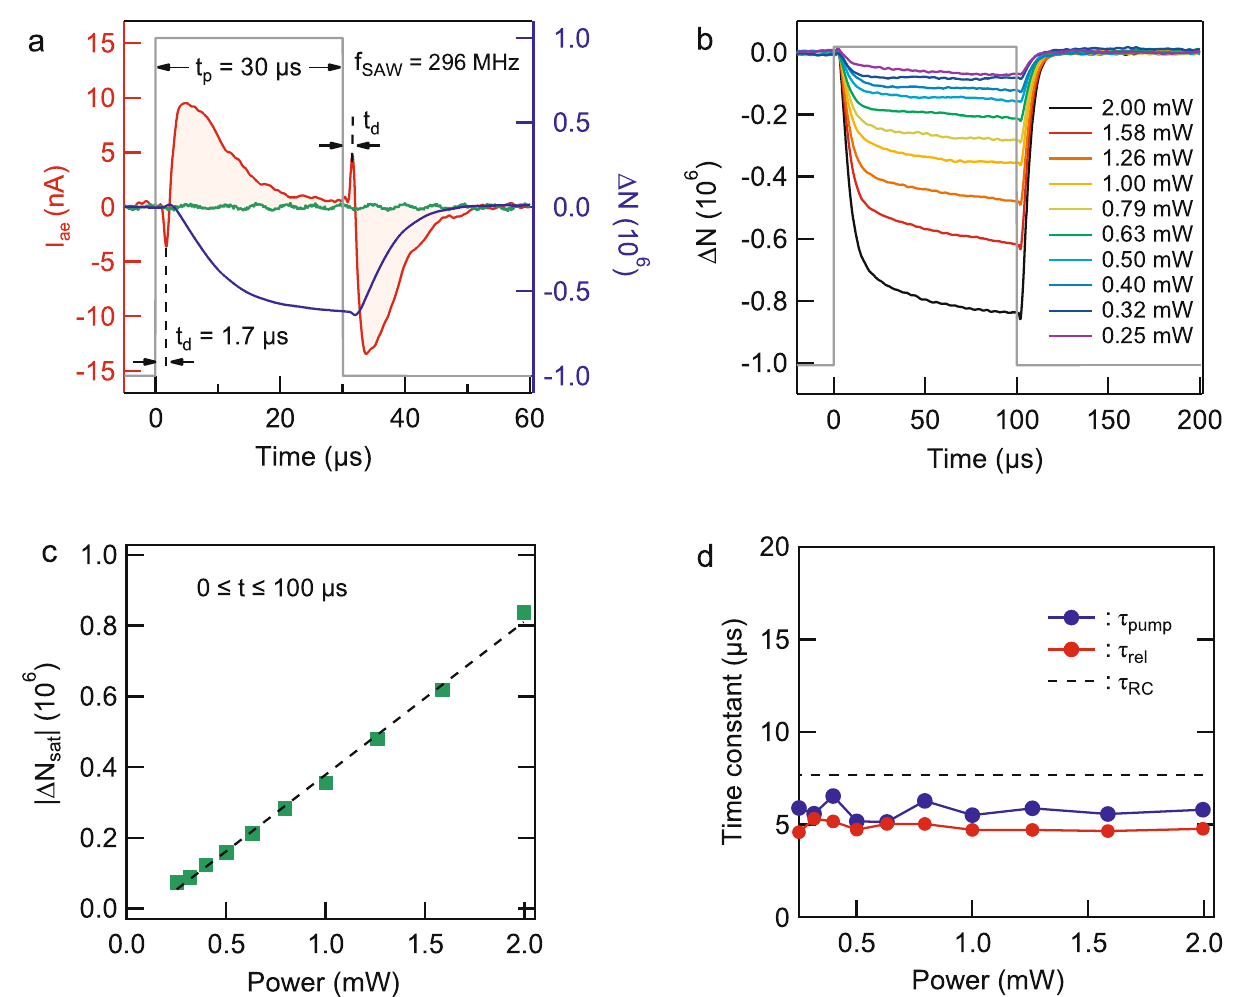
Fig. 3 Time-of- fl ight acoustoelectric measurements of electrons on helium. a Measurement of I ae (red curve) using a gated SAW (gray line) at a fi xed RF power (0 dBm). These measurements were performed at the SAW resonance frequency (296 MHz). In these measurements the number of electrons above the detection electrode is N ≅ 0.4 × 10 9 . The blue trace is the calculated change in the number of electrons Δ N , which is obtained from the time integral of I ae (red trace). We note that I ae is absent when surface electrons are not present (green data trace), revealing that the measured current is induced by the SAW-electron interaction. b Δ N and c ∣ Δ N sat ∣ for a steady-state SAW signal at various values of the driving RF power. The dashed line is a guide to the eye. In these measurements the number of electrons is N ≅ 0.8 × 10 9 . d Dynamical response of two-dimensional electrons on helium to gated SAWs as a function of RF power with N ≅ 0.8 × 10 9 . The time constants τ pump ( τ rel ) are those associated with the rising (falling) edge of the SAWs signal envelope and are determined from fi tting I ae ( t ). The time constant τ RC (dashed line) is that determined from low-frequency transport of electrons on